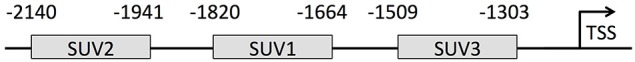
ChIP-qPCR primers targeted to the SUV39H1 promoter. TSS indicates the transcription start site. Numbers indicate the primer start site upstream of the TSS.